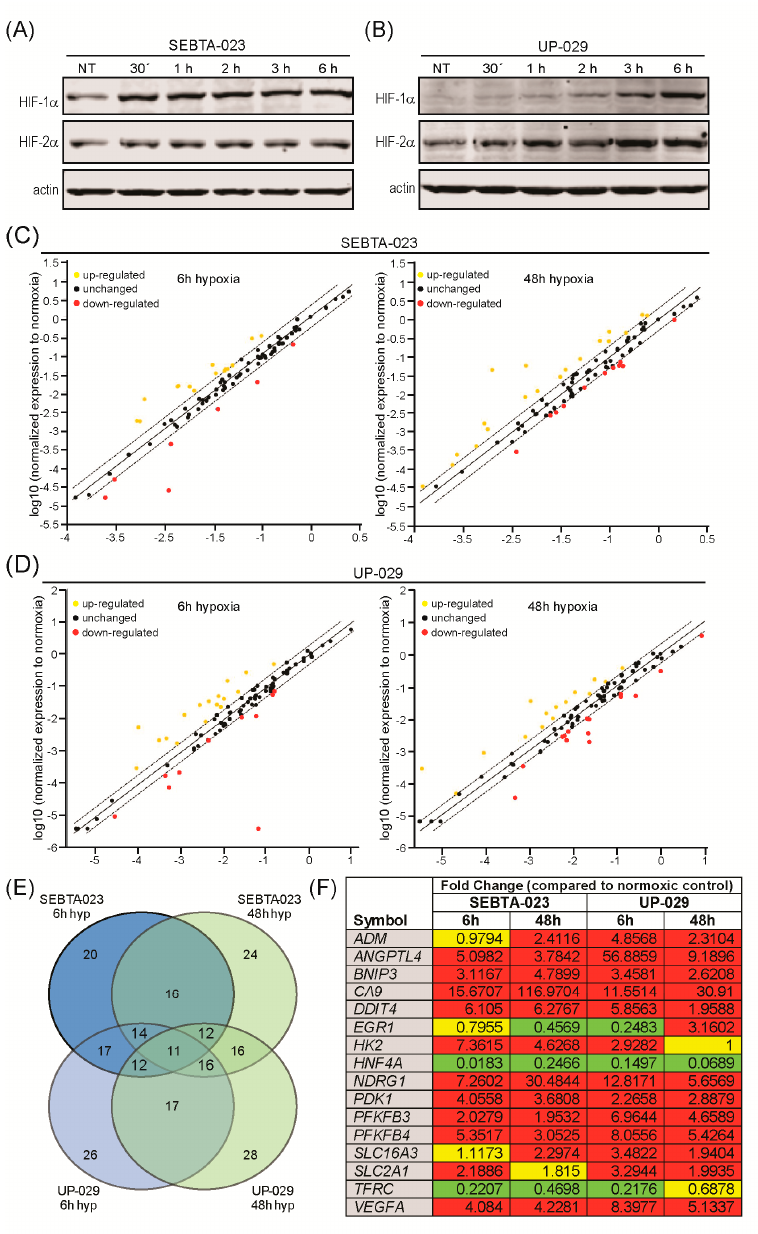
Figure 1. Analysis of hypoxia related genes in SEBTA-023 and UP-029 cell lines. SEBTA-023 and UP-029 cells were either incubated under normoxic (NT) conditions (21% O 2 ) or under hypoxia (1% O 2 ) for the times indicated. ( A ) SEBTA-023 or ( B ) UP-029 cell lysates were prepared and 20 µ g of each protein extract was subjected to SDS-PAGE and analyzed by Western blotting with the antibodies indicated. ( C , D ) RNA extraction was performed using the NZY Total RNA Isolation kit (Nzytech, Lisbon, Portugal). A panel of 86 ROS dependent genes was analyzed using the Hypoxia Signaling Pathway RT 2 Profiler PCR Array (QIAGEN, Manchester, UK). ( C ) Scatter plots for gene expression in hypoxia vs. normoxia in SEBTA-023 cells; ( D ) Scatter plots for gene expression in hypoxia vs. normoxia in UP-029 cells; ( E ) Venn diagram representing di ff erential gene expression in hypoxia vs. normoxia in SEBTA-023 and UP-029 cells. ( F ) Table containing the genes that were di ff erentially expressed in both SEBTA-023 and UP-029 cells throughout the hypoxia time-course. Yellow highlights unchanged genes, red highlights over-expressed genes and green highlights down-regulated genes in hypoxia compared to normoxic